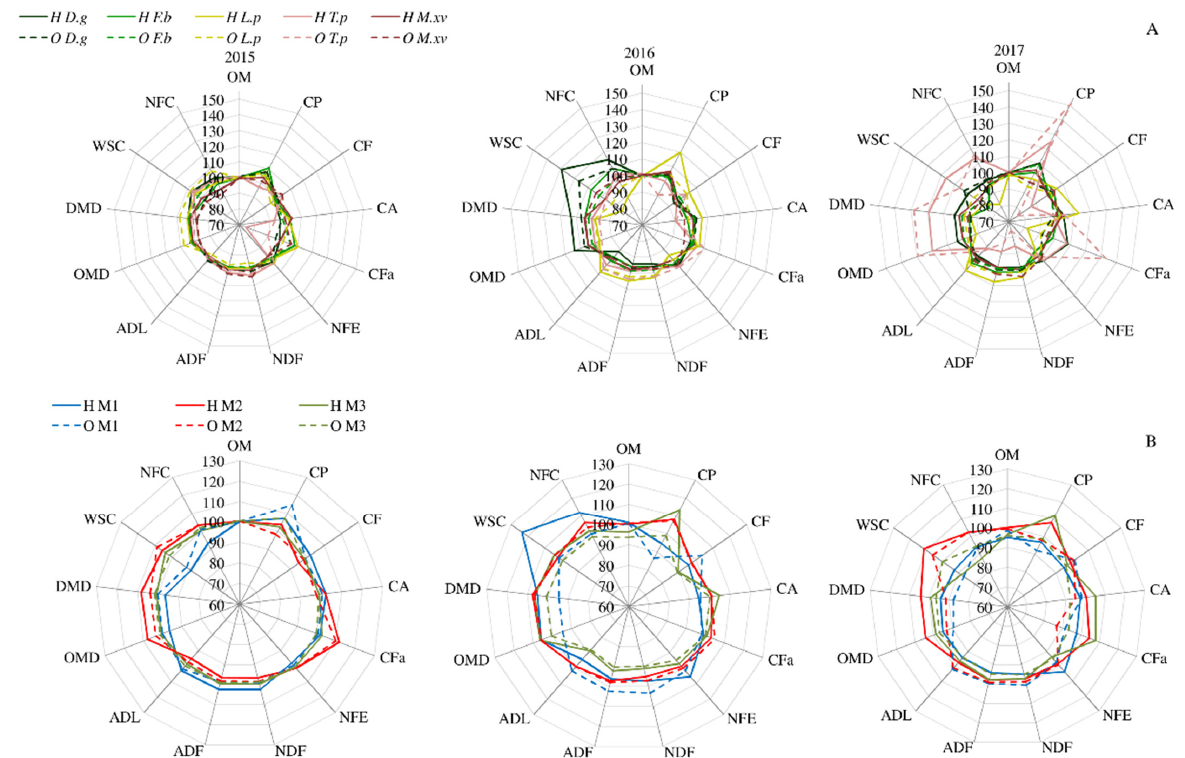
Figure 2. Changes of nutritional parameters content ( A ) in species ( D. glomerata , F. braunii , L. perenne , T. pratense , M.x varia ) and ( B ) in mixtures (M1— D. glomerata , F. braunii , T. pratense ; M2— D. glomerata ,